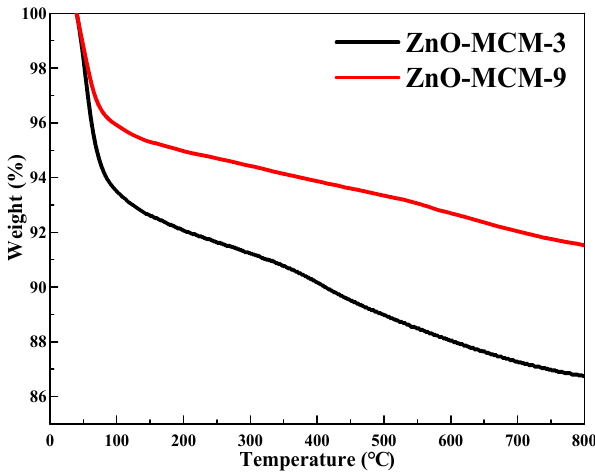
Figure 9. Thermogravimetry (TGA) curves of ZnO-MCM-3 and ZnO-MCM-9.